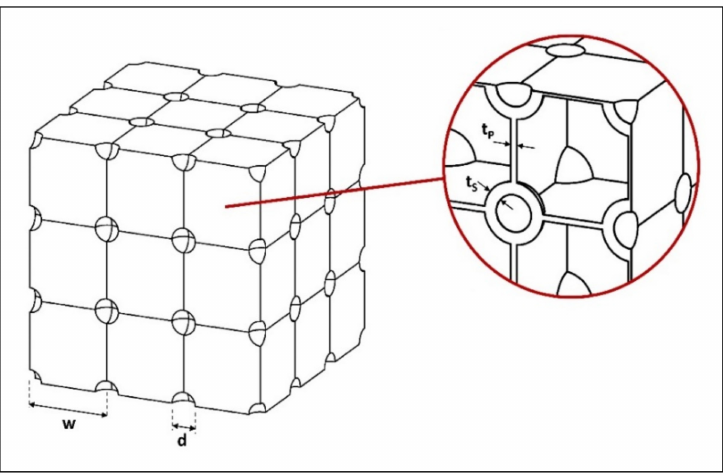
Figure 4. Assumed reference model for closed-cell structure (adapted from ref.